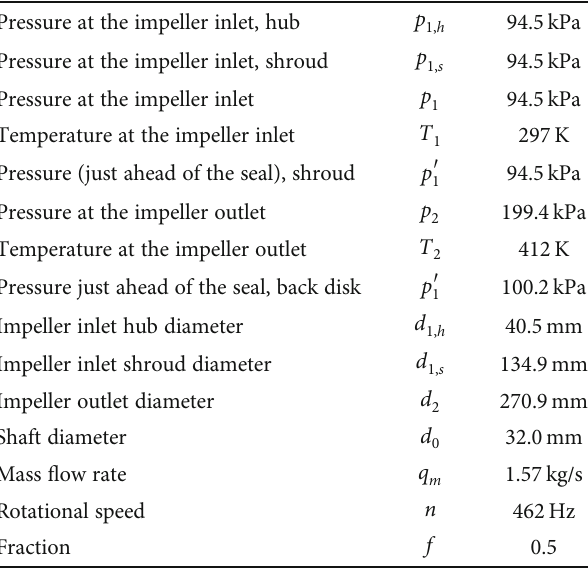
Table 3: Parameters of the studied centrifugal compressor at the point of maximum axial thrust (point 9) used in the method proposed by